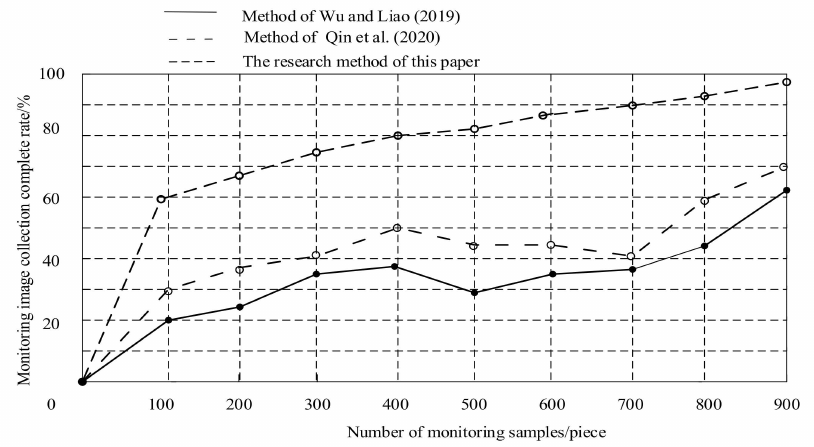
Figure 5. Comparison of complete rate of monitoring image